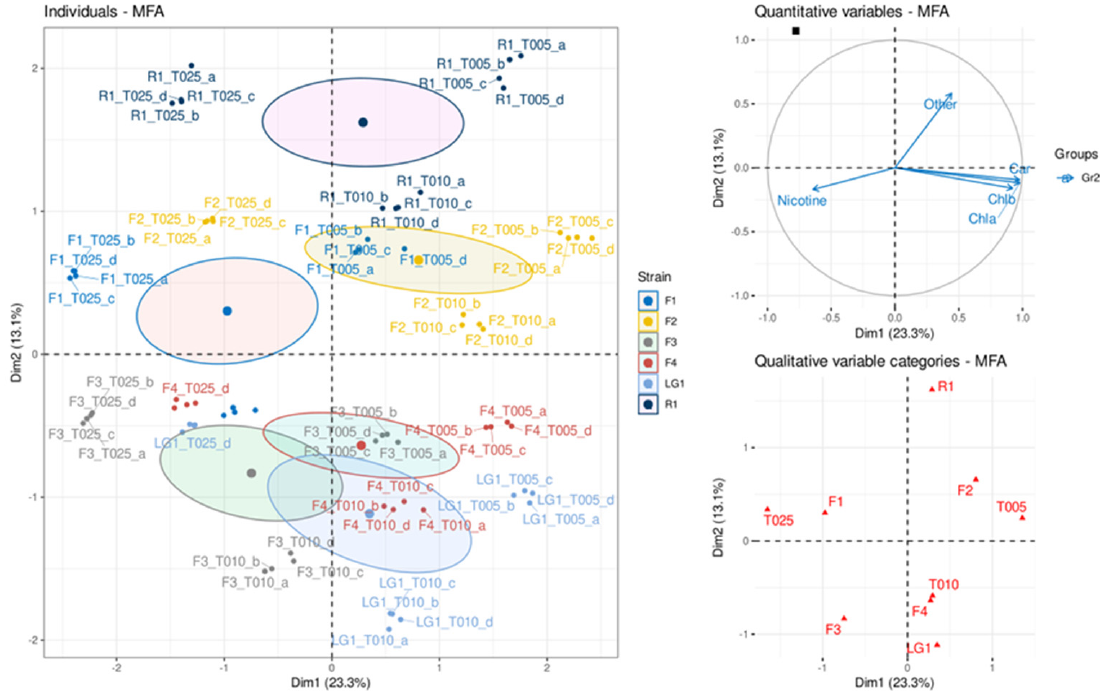
Figure 4. Multiple factor analysis (MFA) of physiological and analytical data in microalgal-based remediation of wastewater from cigarette butts (CB) cleaning process. T005: 5% CB wastewater dilution; T010: 10% CB wastewater dilution; T025: 25% CB wastewater dilution; a, b, c and d: indicate the replicates; Other: pollutants in CB wastewater other than nicotine.